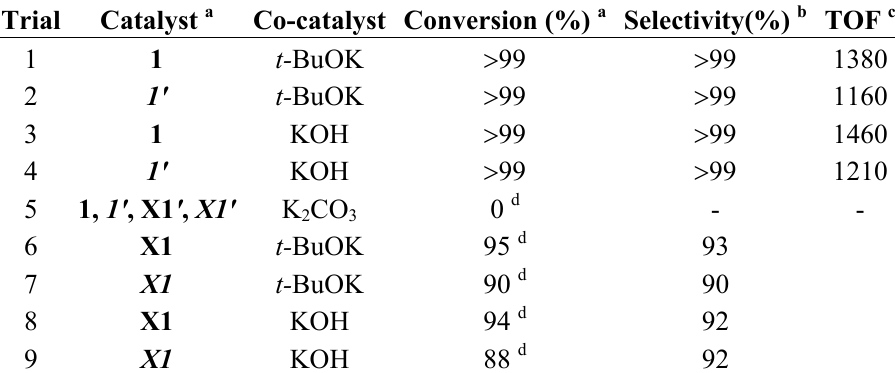
Table 1. Hydrogenation of cinnamaldehyde with different